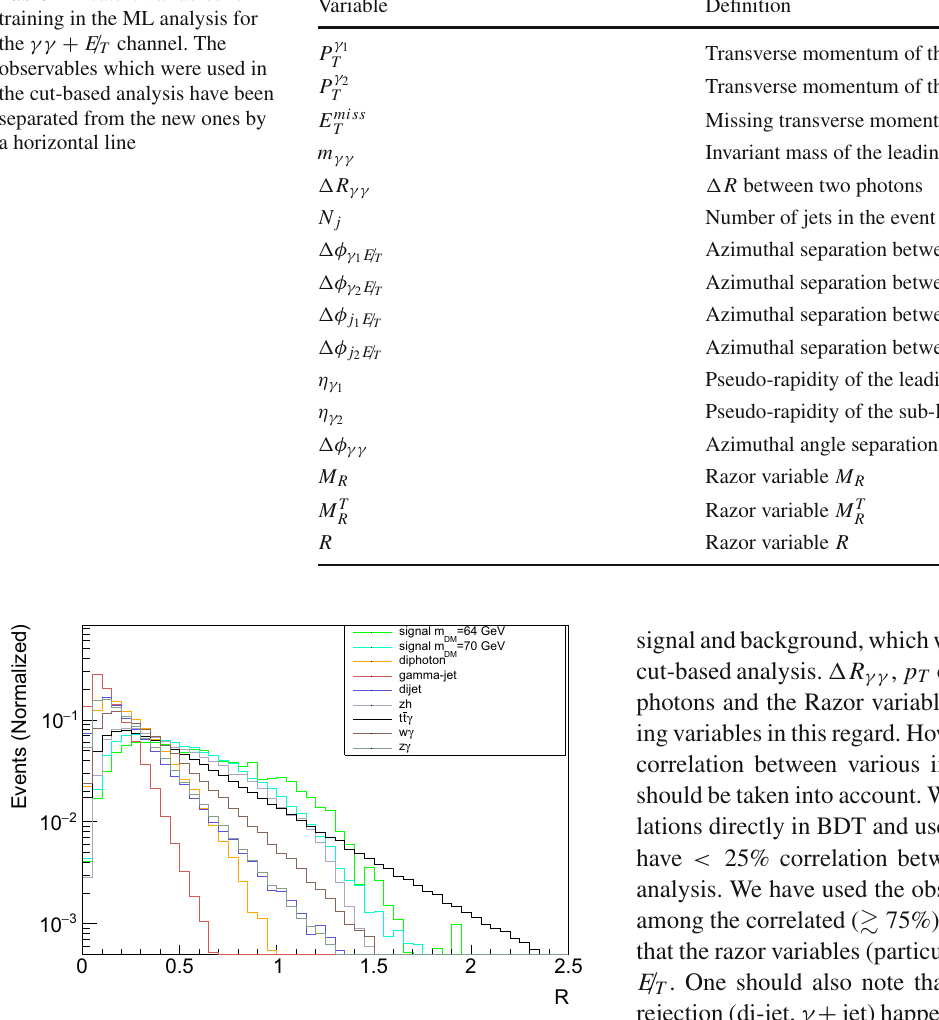
Fig. 16 Normalized distribution of Razor variable R for signal and